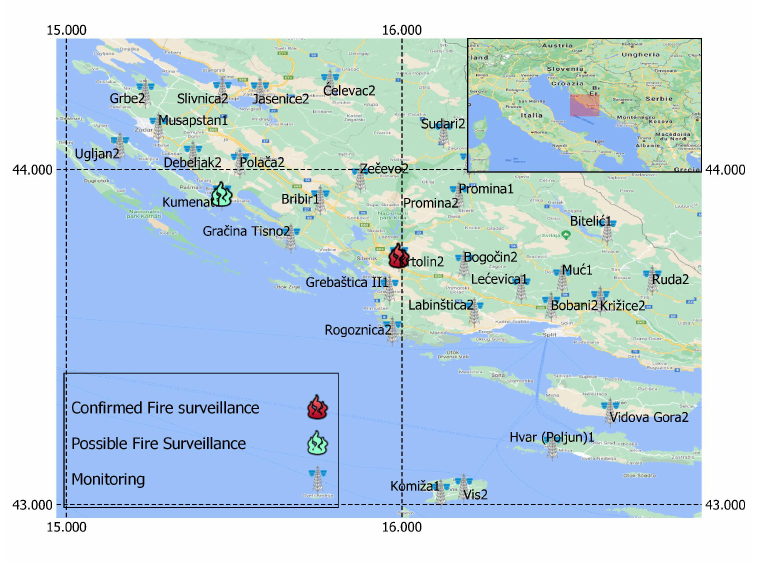
Figure 6. Environmental monitoring system displaying the status of various